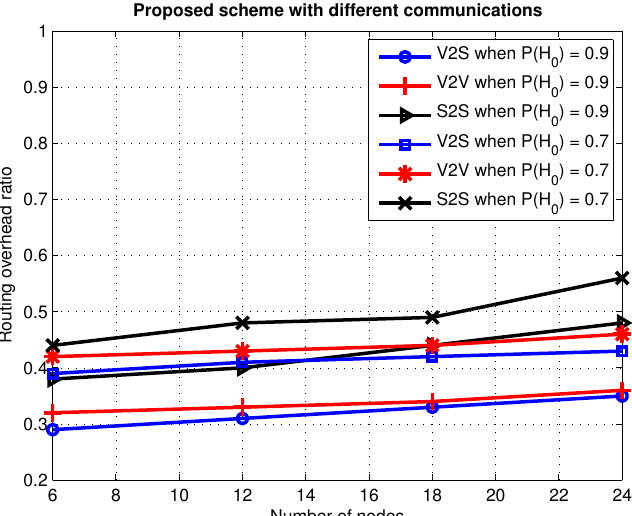
Figure 6. Performance comparison between the proposed hybrid and pure communications in terms of routing overhead